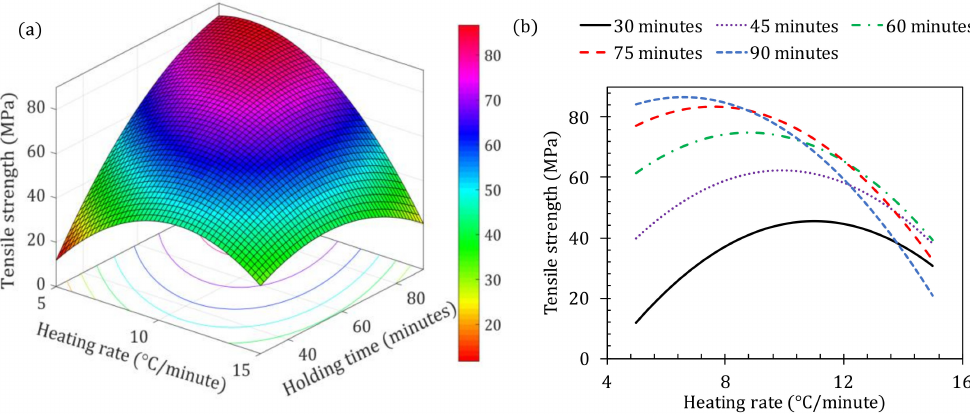
Figure 4. ( a ) 3D surface plot between tensile strength, heating rate, and holding time; ( b ) interaction plot between heating rate and holding time showing the effect on the tensile